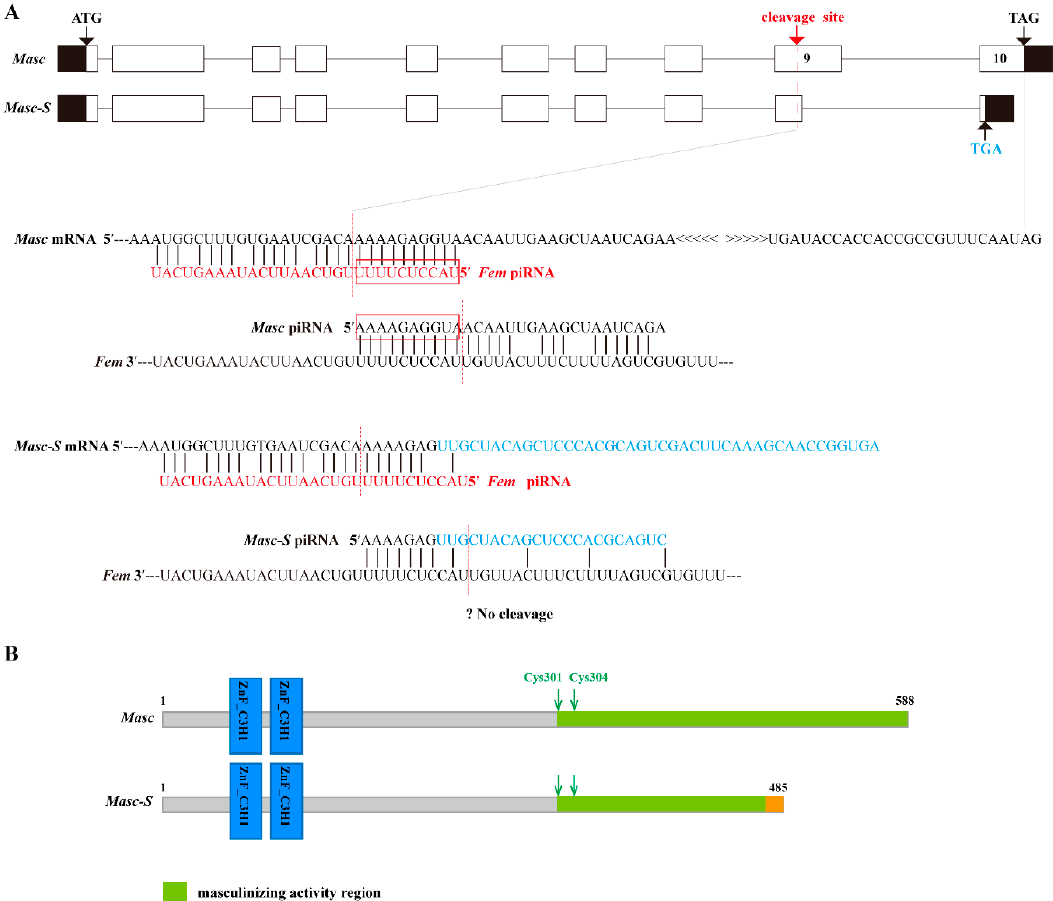
Figure 1. Schematic diagram for gene and protein domain structure of Masc and splice variant Masc-S . ( A ) The exonic structure of Masc and its splice isoform Masc-S was shown. The exons are represented by boxes and introns by a line. Coding and untranslated regions are indicated by white and black boxes, respectively. ATG: Starting codon, TAG/TGA: Stop codon. Masc-S lacked the sequence of nucleotides 1417–1603 of the Masc CDS, which is a part of exon 9. The red dotted line represents Fem piRNA cleavage site located in exon 9. For Masc mRNA, Fem piRNA and Masc piRNA both can participate in the ping-pong cycle of the piRNA amplification loop [7] . The red boxes represented the ping-pong signature. For Masc-S mRNA, the lacking region of the splice variant was closely adjacent to the Fem piRNA cleavage site (7 nt away), and the region of the cleavage site is di ff erent from Masc mRNA (shown as the sequence in blue). The putative Masc-S piRNA, if any, is unable to work. ( B ) Schematic diagram of the protein structure of Masc and Masc-S